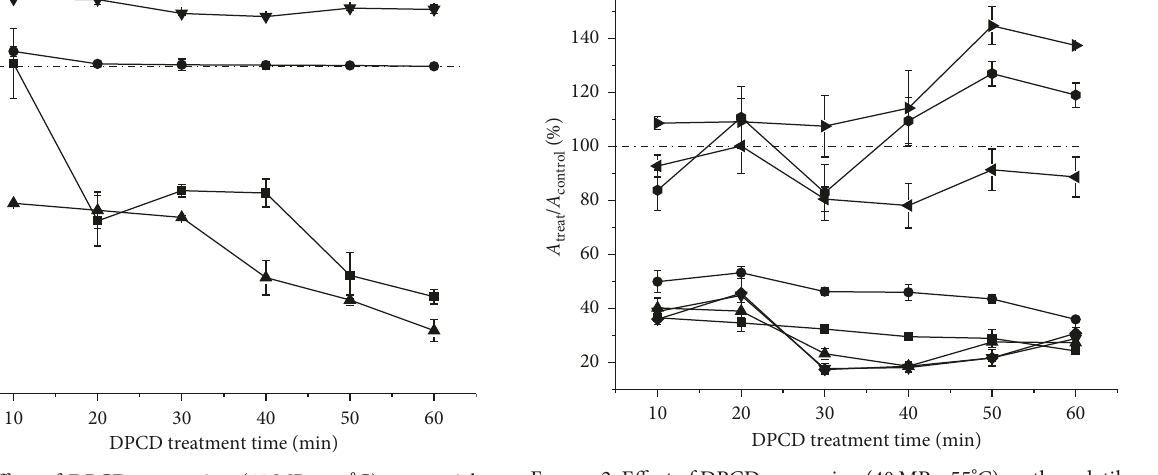
Figure 2: Effect of DPCD processing (40MPa, 55 ° C) on the volatile Figure 1: Effect of DPCD processing (40 MPa, 55 ° C) on particle components in orange juice during 60min: , nonanal; , citro- ; , a ; , b . Each size and color in orange juices: , D (4,3); , L nellol; , linalool; , trans -2-hexenol; , ethyl butyrate; , -pinene; value represents mean standard deviation of three replicates. V in ∗ ∗ ∗ , phellandrene; , limonene. Each value represents the the y -axis indicates the determined value of D (4,3), L , a , and b , mean standard deviation of three replicates, and A in the y -axis taking the average value of the untreated sample as control. α ± ∗ ∗ ∗ denotes the peak area of the volatile compounds, taking the average value of the untreated sample as control. ± Table 1: Linear regression analysis of DPCD treatment time on 12 parameters of orange juice. Regression equation 0.9648